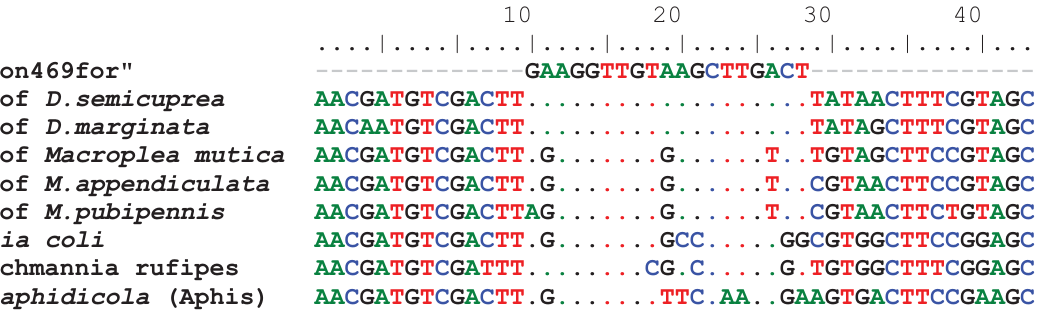
Figure 2. Alignment of the primer Don469for to the corresponding partial sequence of the 16SrRNA of symbionts of Donacia and Macroplea species, as well as sequences of three further Enterobacteriaceae, which show different levels of relatedness to reed beetle symbionts (cf.